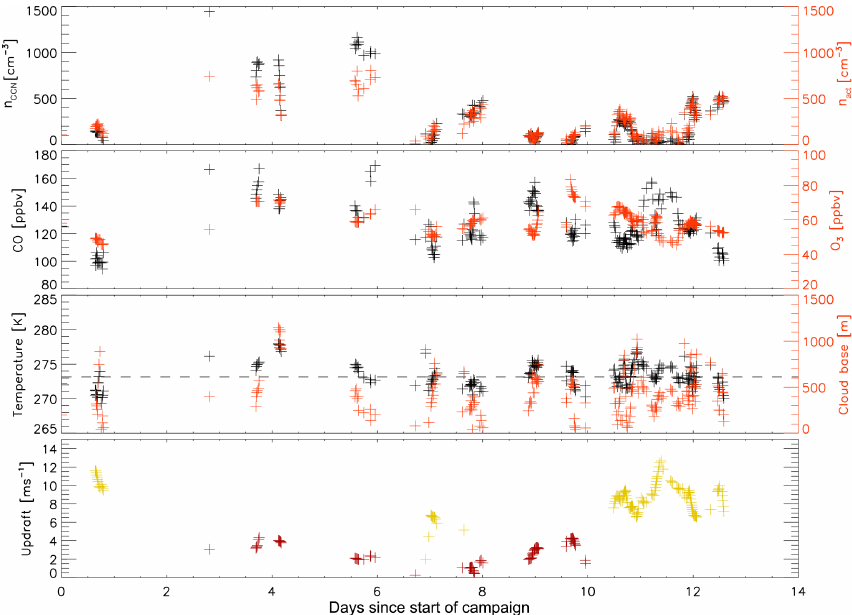
Figure 4. As for Fig. 1 but for CLACE2002. Note that the axis ranges differ from those in Fig. 1.